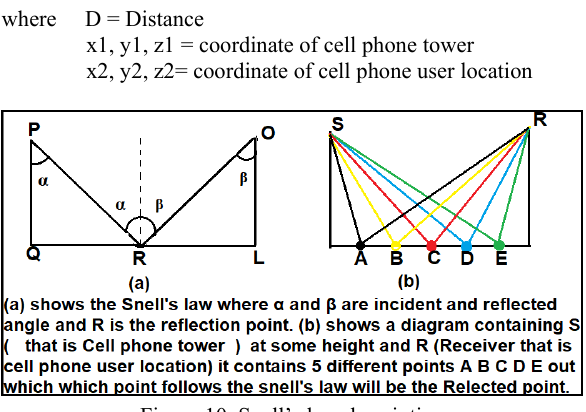
Figure 10. Snell’s law description